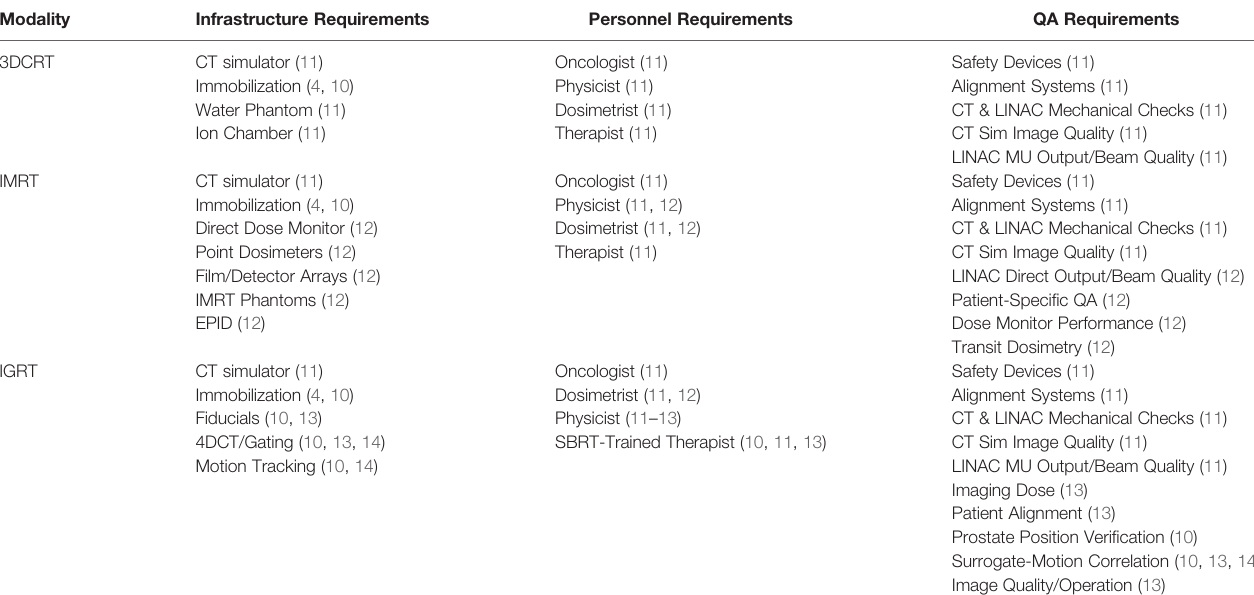
TABLE 2 | A summary of prostate cancer HFRT technical